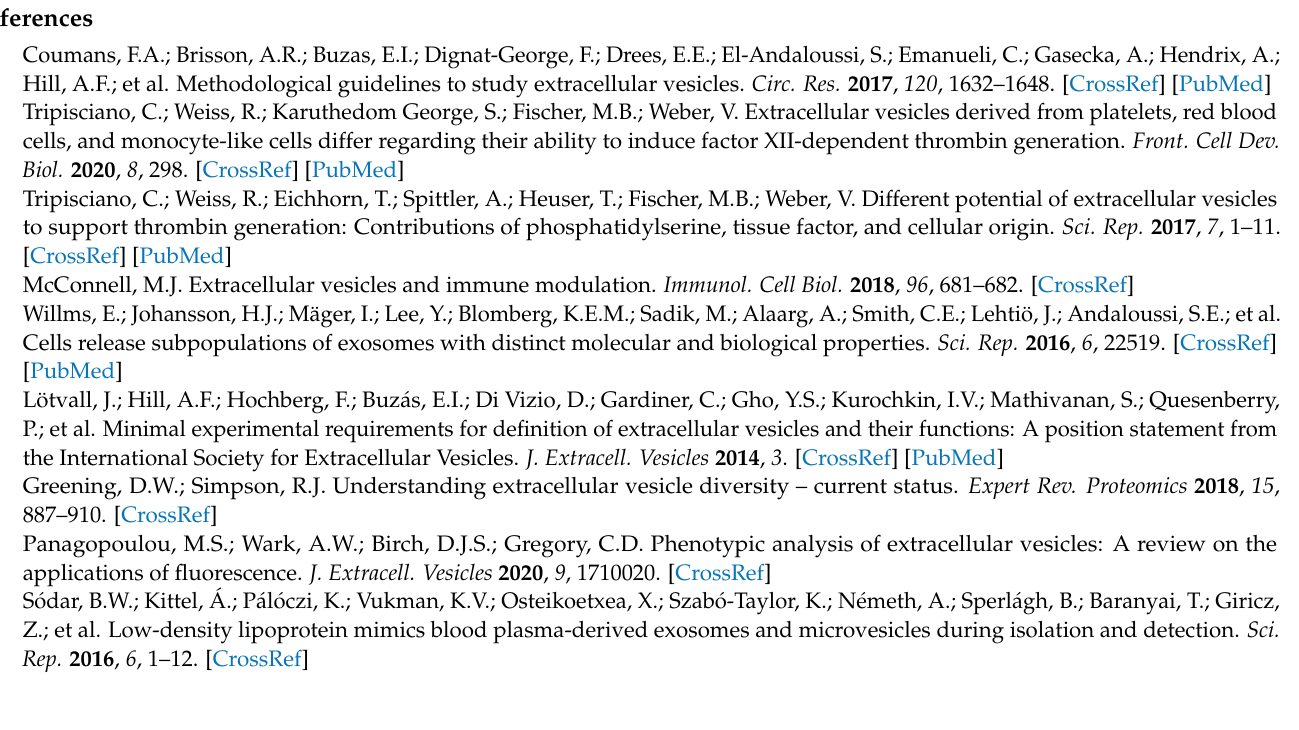
Table S2: Frequencies (cm − 1 ) of the most important FT-IR absorption bands of platelet-derived